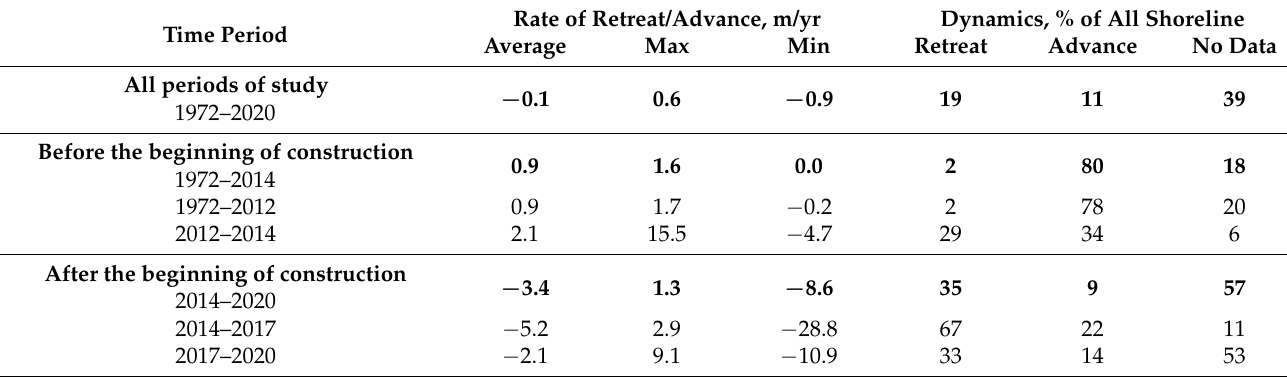
Table 2. Dynamics of the vegetation